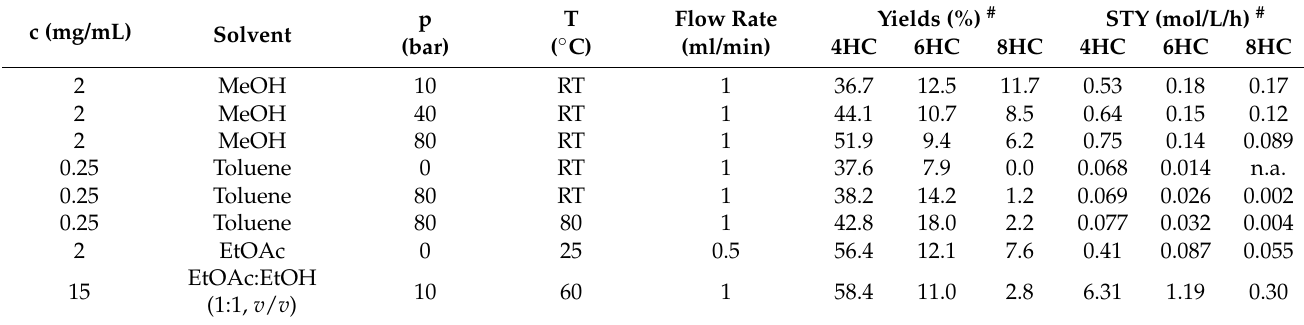
Table 1. Reaction conditions of the continuous flow hydrogenation of curcumin, and yields achieved for tetra-, hexa-, and octahydrocurcumin (DMC, 4HC, 6HC and 8HC respectively). p: pressure set on the instrument, EtOAc: ethyl acetate, T: temperature, STY: space time